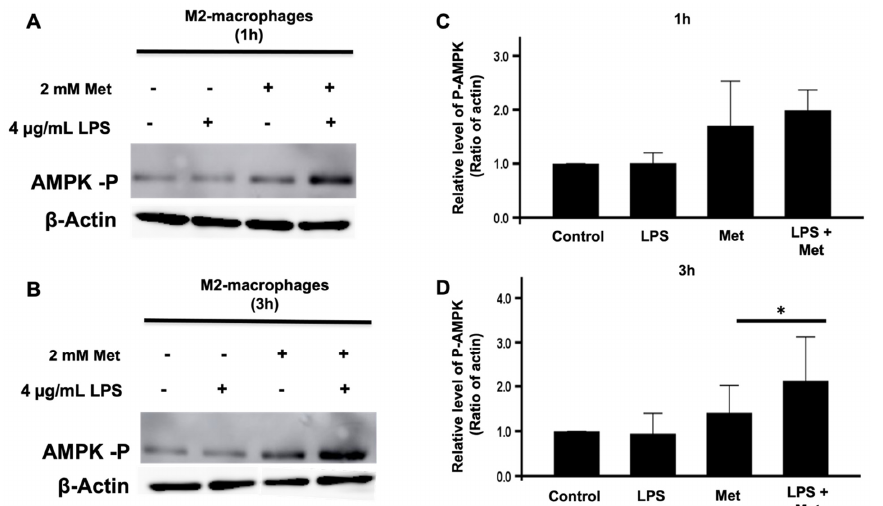
Figure 6. Effect of metformin on the phosphorylation of AMPK in M2 macrophages. M2 macrophages were incubated in the absence or presence of metformin (2 mM), then stimulated with LPS (4 µg/mL) for 1 ( A ) and 3 h ( B ). The phosphorylation of AMPK and the presence of actin were evaluated by SDS-PAGE and Western blot using specific antibodies. The corresponding bands for 1 hour ( C ) and 3 hours ( D ) from three experiments were quantified and expressed as mean ± SD (n = 3, * p < 0.05). Biomedicines 2022 , 9 , x FOR PEER REVIEW 3.6. AMPK Plays the Role of a Brake of ROS Production by Human and Mice Phagocytes To investigate if, indeed, AMPK could inhibit ROS production in phagocytes, we first used 5-aminoimidazole-4-carboxamide ribonucleotide (AICAR), a known more potent AMPK activator than metformin [48,49]. We incubated human monocytes with 1 mM AICAR for 45 min and stimulated them with N -formyl-methionyl-leucyl-phenylalanine (fMLF), a potent inducer of ROS production. ROS production was measured by luminol- amplified chemiluminescence and results show that AICAR significantly decreased ROS